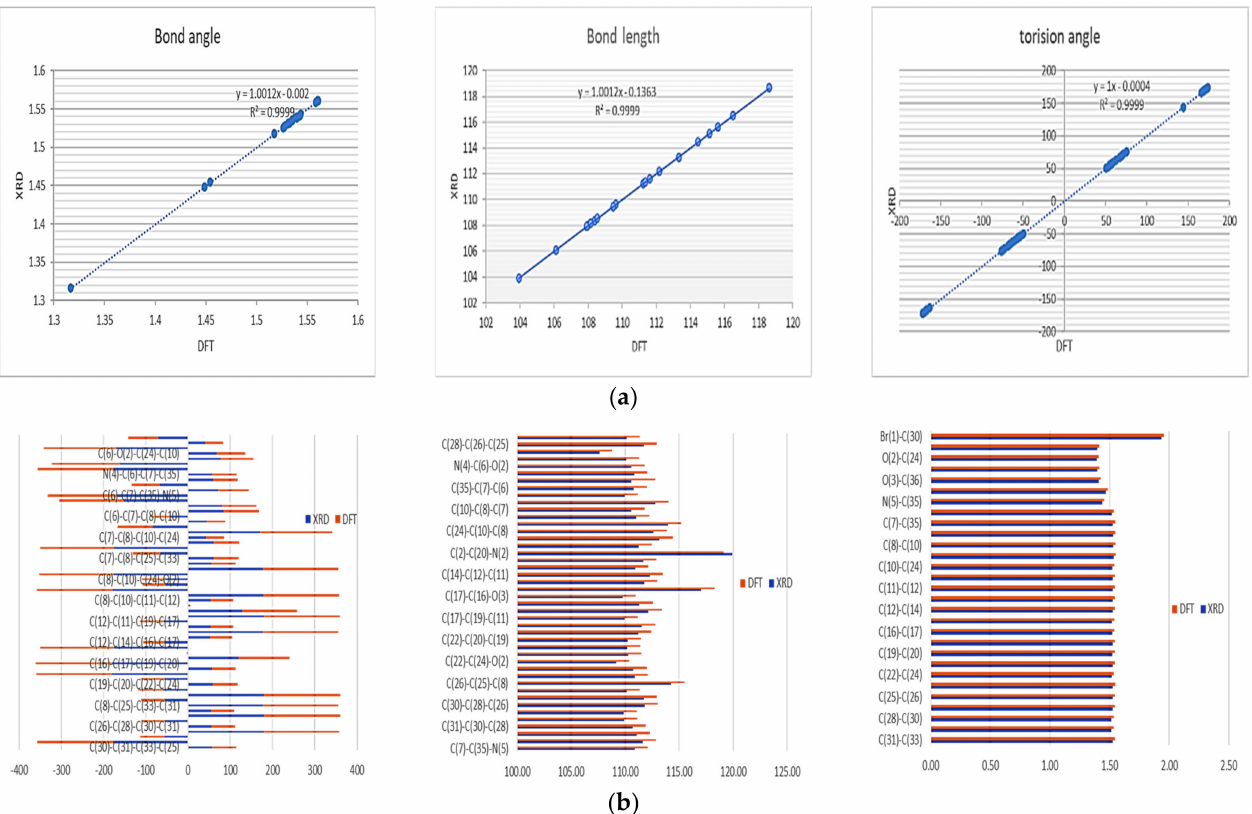
Figure 5. ( a ) The experimental XRD and DFT parameters. ( b ) Straight − line correlation for the geometric optimization parameters between the experimental and theoretical